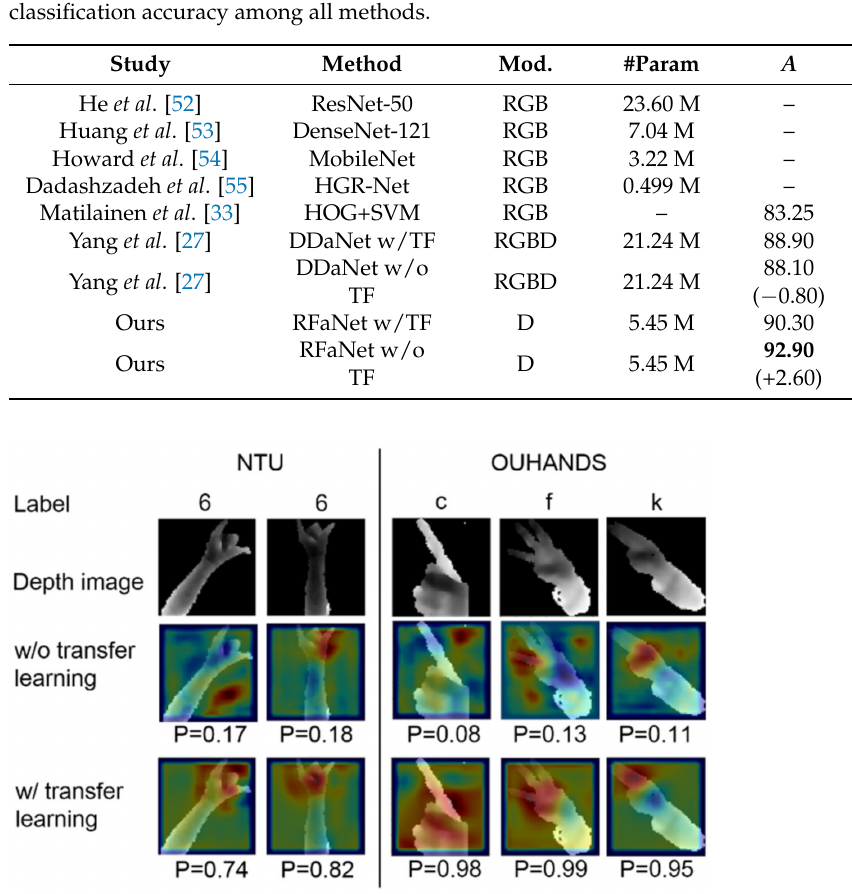
Table 6. Results of the transfer learning where OUHANDS is the target dataset. Numbers in parentheses indicate the performance difference between networks with and without transfer learning.